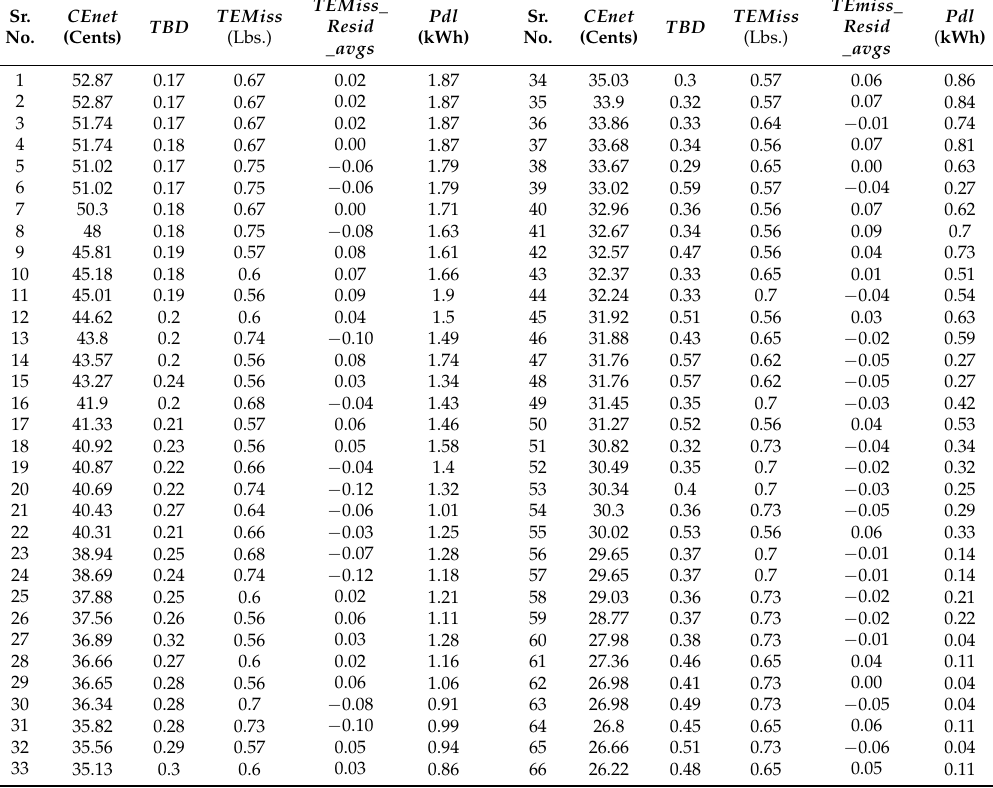
Table 11. Trade-offs achieved after applying AVCF based on Algorithm 2 (Step-2). Sr.